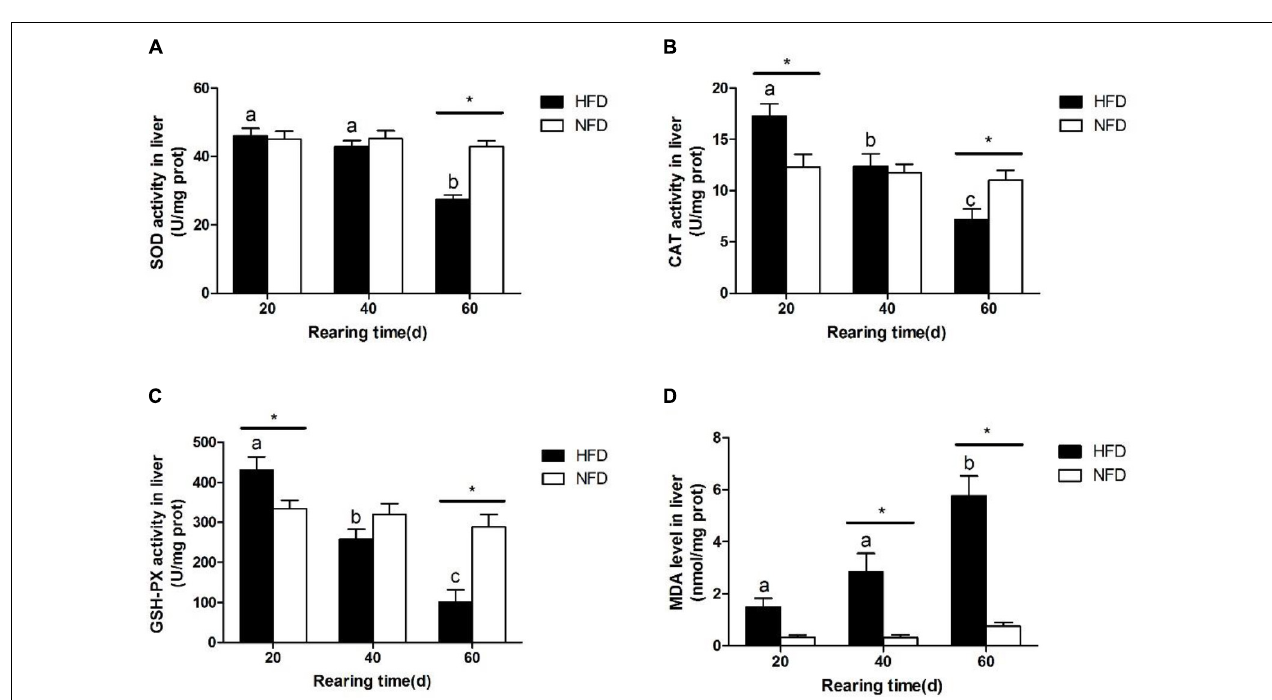
FIGURE 3 | Oxidative stress status in liver of GIFT fed experimental diets on day 20, 40, and 60 ( n = 9 replicates per group). (A) Superoxide dismutase, SOD; (B) catalase, CAT; (C) glutathione peroxidase, GSH-Px; (D) malondialdehyde, MDA. Significant differences ( P < 0.05) between high-fat diet (HFD) and normal-fat diet (NFD) groups at same sampling time are marked by asterisks ( ∗ ). Different superscript lowercase letters show significant differences ( P < 0.05) in HFD group among different sampling times.